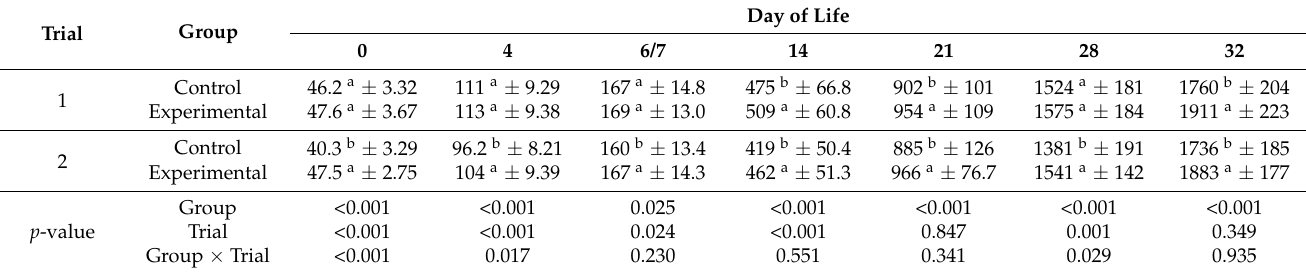
Table 5. Average BW (g) depending on different diets and different trials ( n = 100 each) using two-factorial analysis. Trial